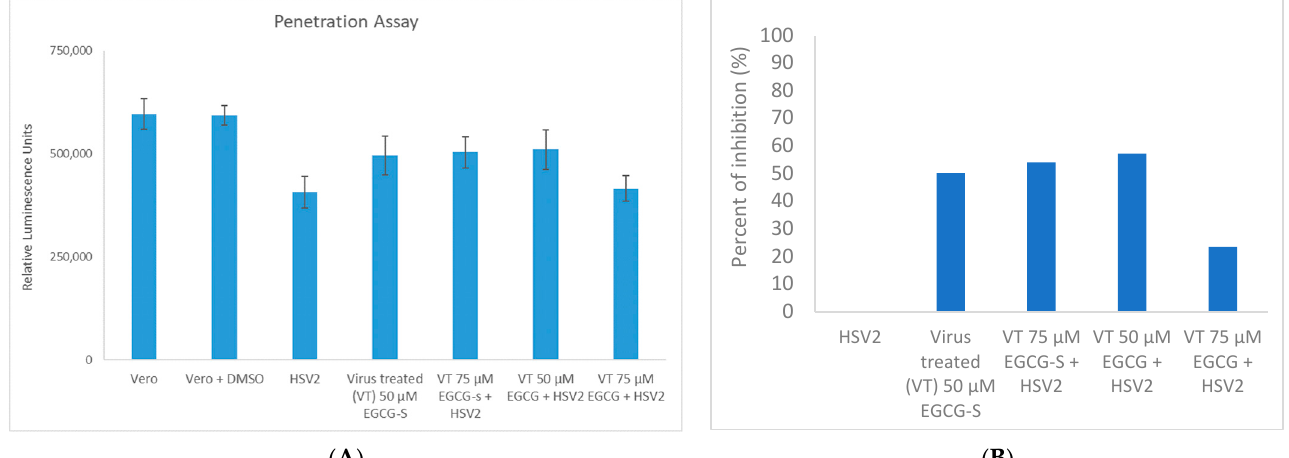
Figure 5. ToxGlo TM penetration assay with Vero cell monolayers infected with HSV-2 (MOI = 0.1) in the presence of 50 µM EGCG-S, 75 µM EGCG-S, 50 µM EGCG, and 75 µM EGCG, respectively. Unadsorbed virus was deactivated with PBS (pH 3) for 1 min and PBS (pH 11) to neutralize the acidic pH. Treatment of HSV-2 with 50 µ M and 75 µ M concentrations of EGCG and EGCG-S had some effect on the penetration step of the infection process. ( A ) Cell viability as measured by luminescence 48 hpi indicates that treatment of virions with 50 and 75 µ M concentrations of EGCG and EGCG-S increased cell viability compared with untreated HSV-2. ( B ) The percent inhibition of penetration stage of HSV-2 infection when virions were treated with 50 and 75 µ M concentrations of EGCG and EGCG-S is